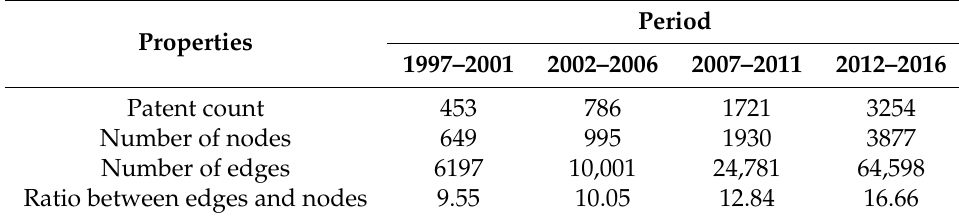
Table 2. Network properties of shale petroleum technologies’